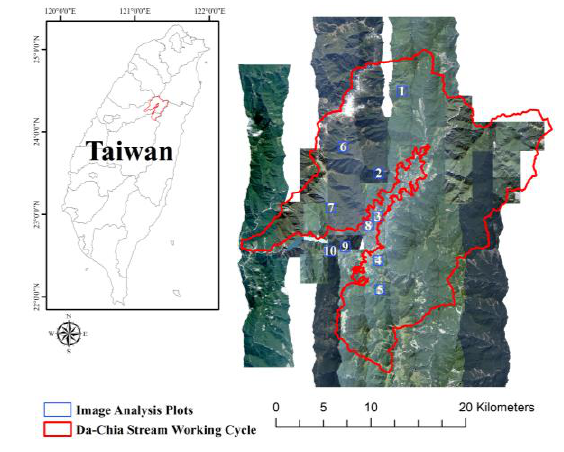
Figure 1. The location of the study area (the numbers in map are plot